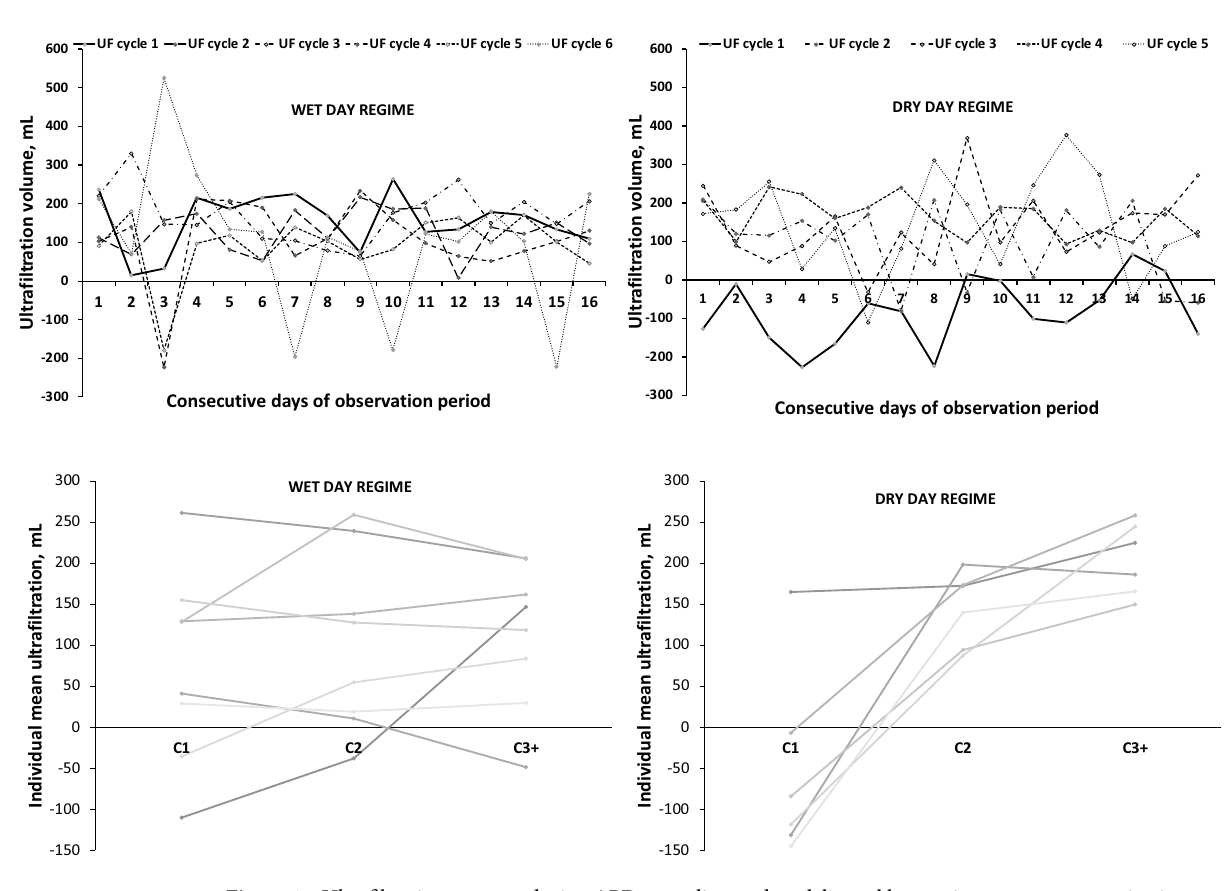
Figure 1. Ultrafiltration patterns during APD according to data delivered by continuous remote monitoring. Upper panel: Net ultrafiltration volume (in mL) of each APD exchange during the observation period of 16 days for two patients undergoing APD with wet day (APD WD with 6 night exchanges) and dry day (APD DD with 5 night exchanges) regimes respectively. Net UF from each cycle/exchange of the APD session is denoted by a different colour. The bold, solid line corresponds to net UF from first cycle obtained during consecutive days. Bottom panel: Individual values of mean net ultrafiltration (in mL) in the first (C1), and second (C2) cycle, and the mean values of the following cycles (C3 +) during the observation period of 16 days for each of the 14 patients undergoing either APD WD (n = 8) or APD DD (n =